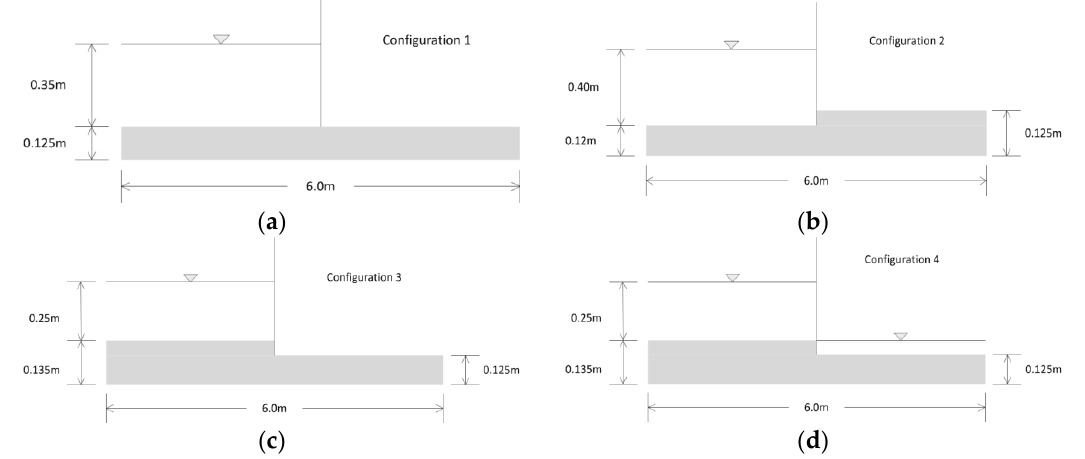
Figure 4. Initial Configurations for dam-break over sand bed: ( a ) Configuration 1; ( b ) Configuration 2; ( c ) Configuration 3; and ( d ) Configuration 4.